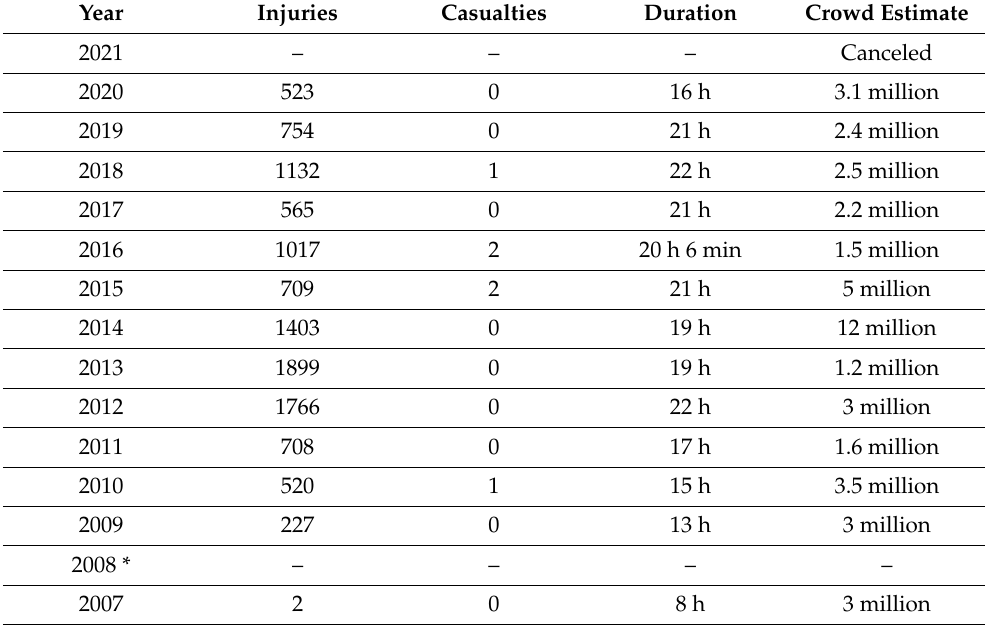
Table 1. Traslacion in numbers 5